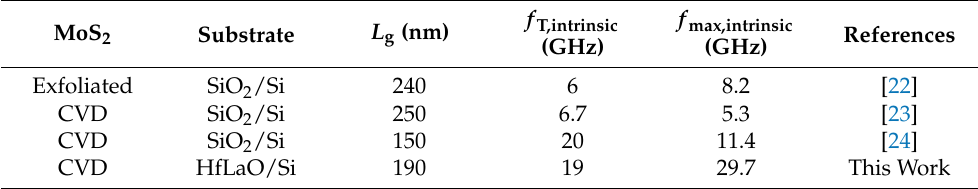
Table 1. Comparison of reported MoS 2 RF transistors with comparable gate